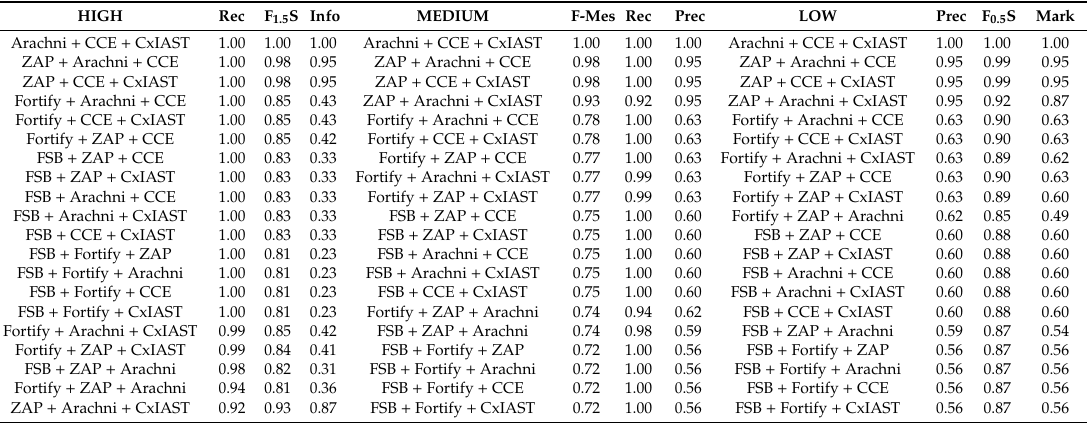
Figure 7. Rankings for ( a ) high, ( b ) medium and ( c ) low criticality levels for 2-tools combinations. Table 10. Ranking of 3-tools combinations according to distinct level of web application